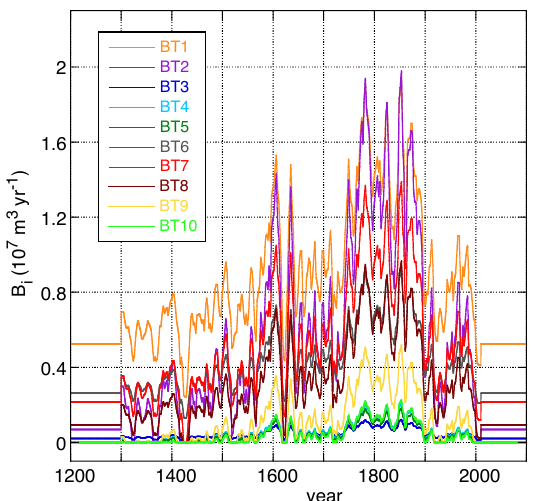
Figure 9. Mass input from the 10 tributary basins and glaciers for Fig. 9. Mass input from the ten tributary basins and glaciers for the simulation shown in Fig. 2 the simulation shown in Fig. 8. The location of the basins is shown 8. The location of the basins is shown in Fig. 1. 3 in Fig. 1.